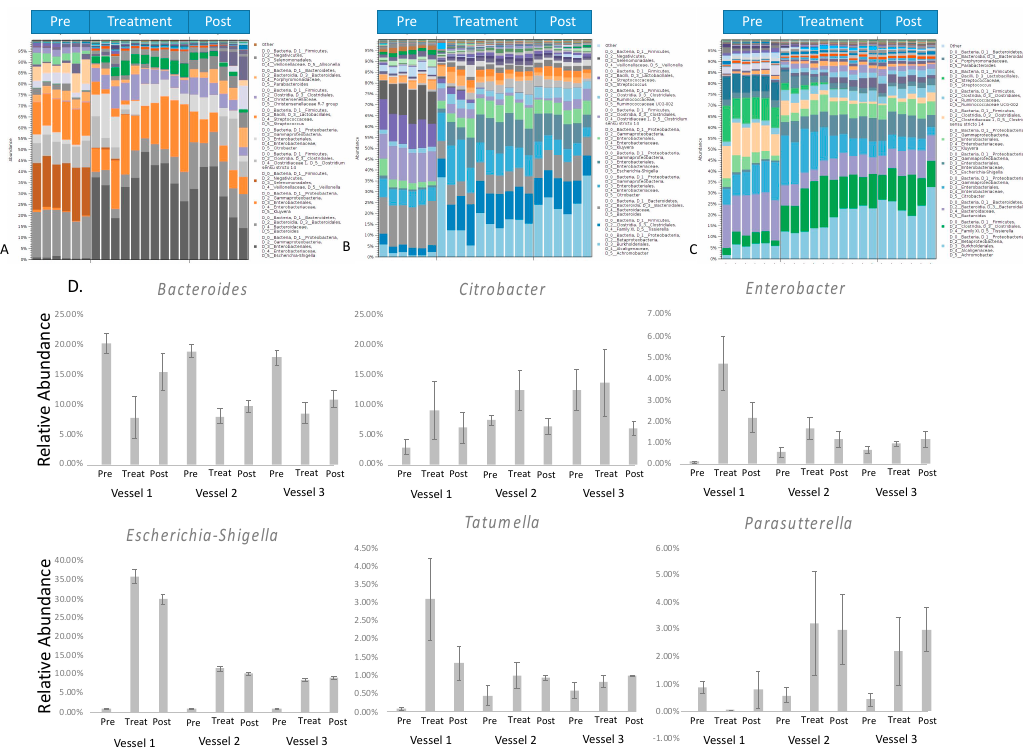
Figure 4. Bar charts representing bacterial taxonomy based on the 16 S rRNA gene at the genus level in 3 parts of the HCM (( A ). Vessel 1; ( B ). Vessel 2; ( C ). Vessel 3). ( D ). The relative abundance of the significant genus in a three-time period. DNA was isolated from vessel contents for MiSeq sequencing. The relative abundance of bacteria was calculated based on the operational taxonomic unit (OTUs). The Y -axis represents the relative abundance of each detected genus.